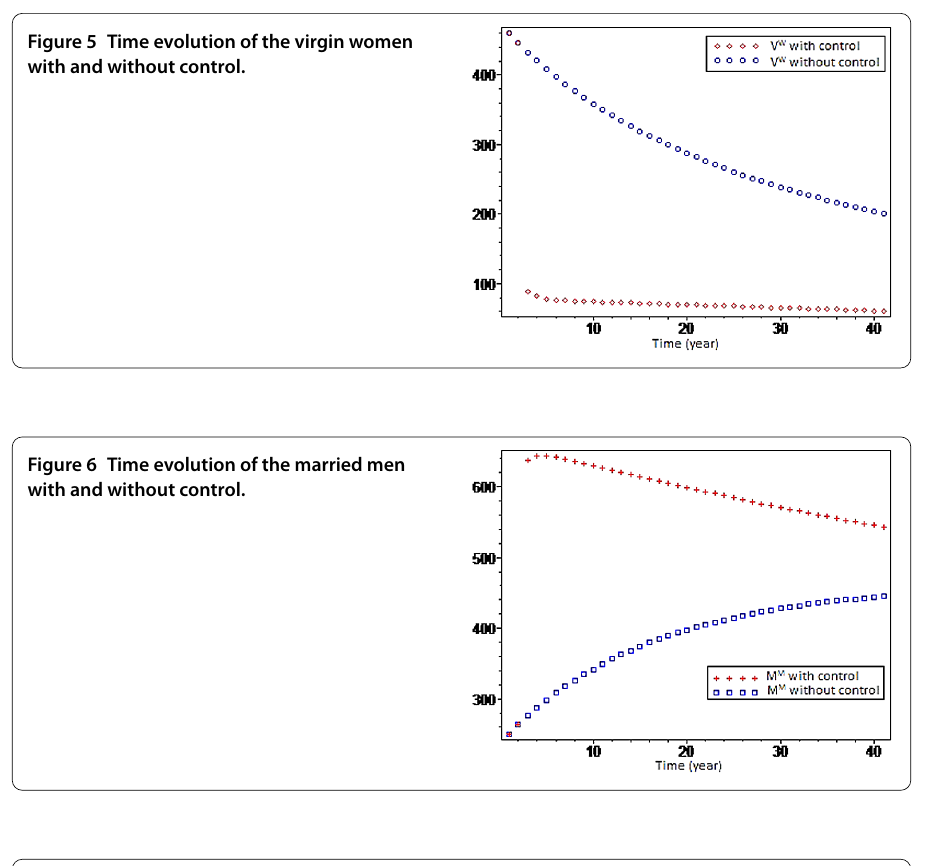
Figure 7 Time evolution of the married women with and without control.